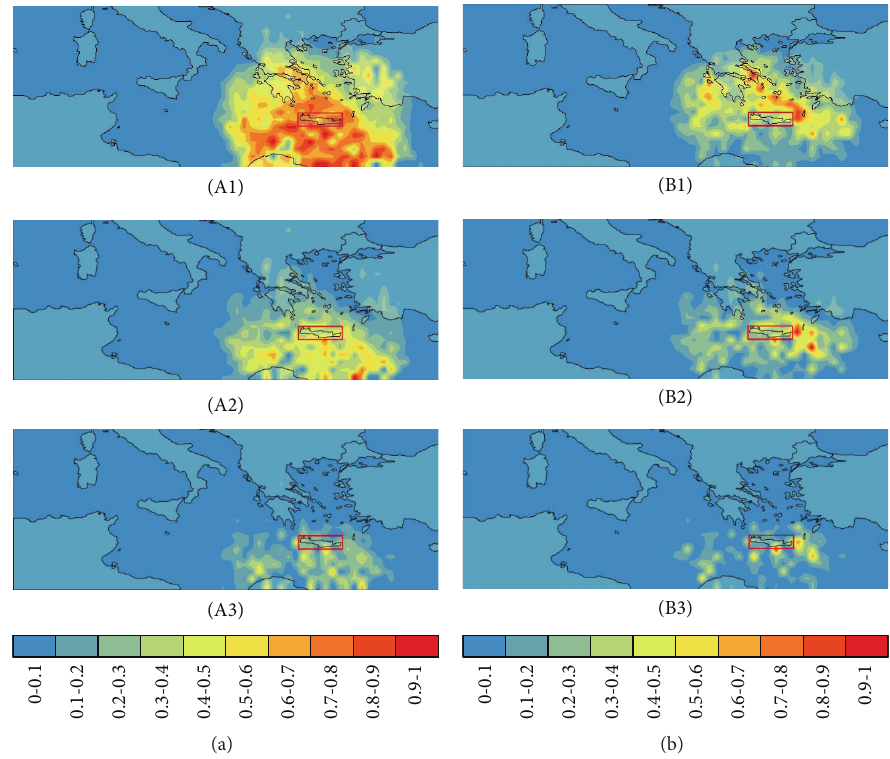
Figure 4: Spatial probability maps (a) and weighted-normalized probability maps (WNP) (b) of “hitting” cyclones for the time period 1979– 2011 for (1) light, (2) medium, and (3) heavy rain